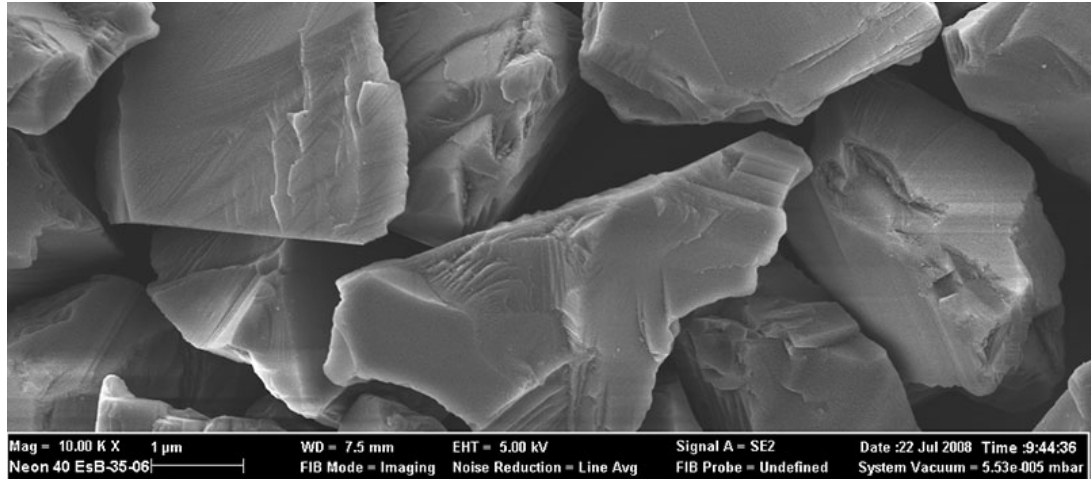
Figure 1. Scanning electron microscopy (SEM) image of raw diamond powder 5 µ m class before the high temperature and high pressure (HTHP) process.